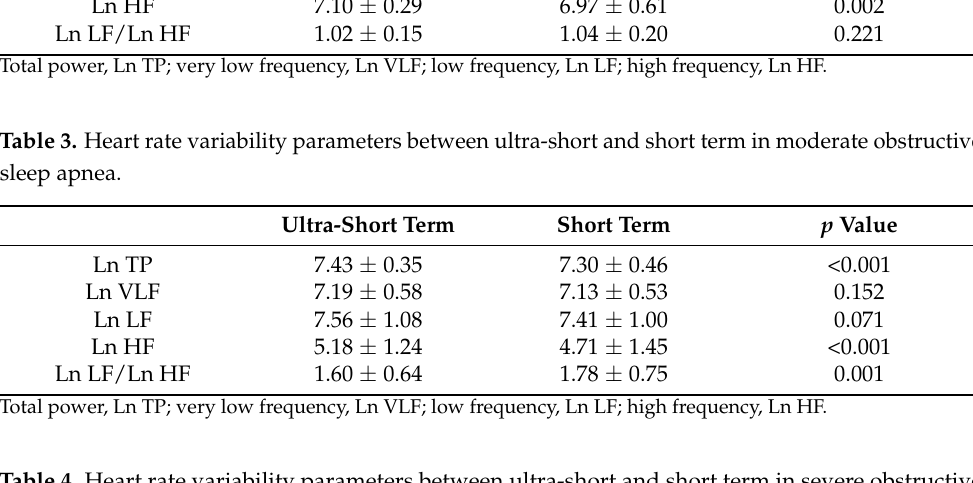
Table 4. Heart rate variability parameters between ultra-short and short term in severe obstructive sleep